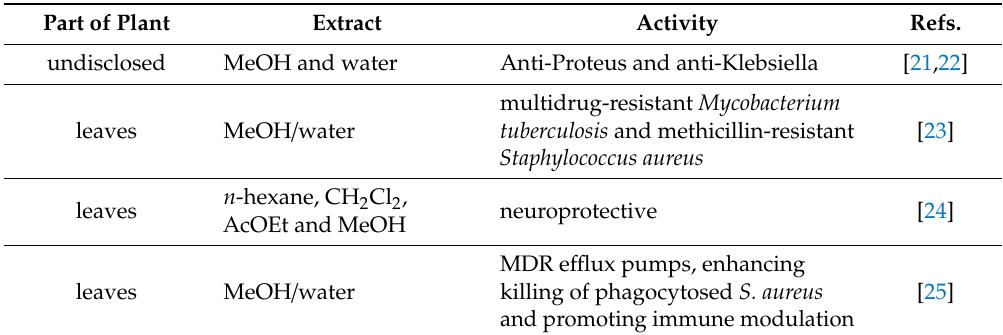
Table 1. Biological activity of extracts of Carpobrotus